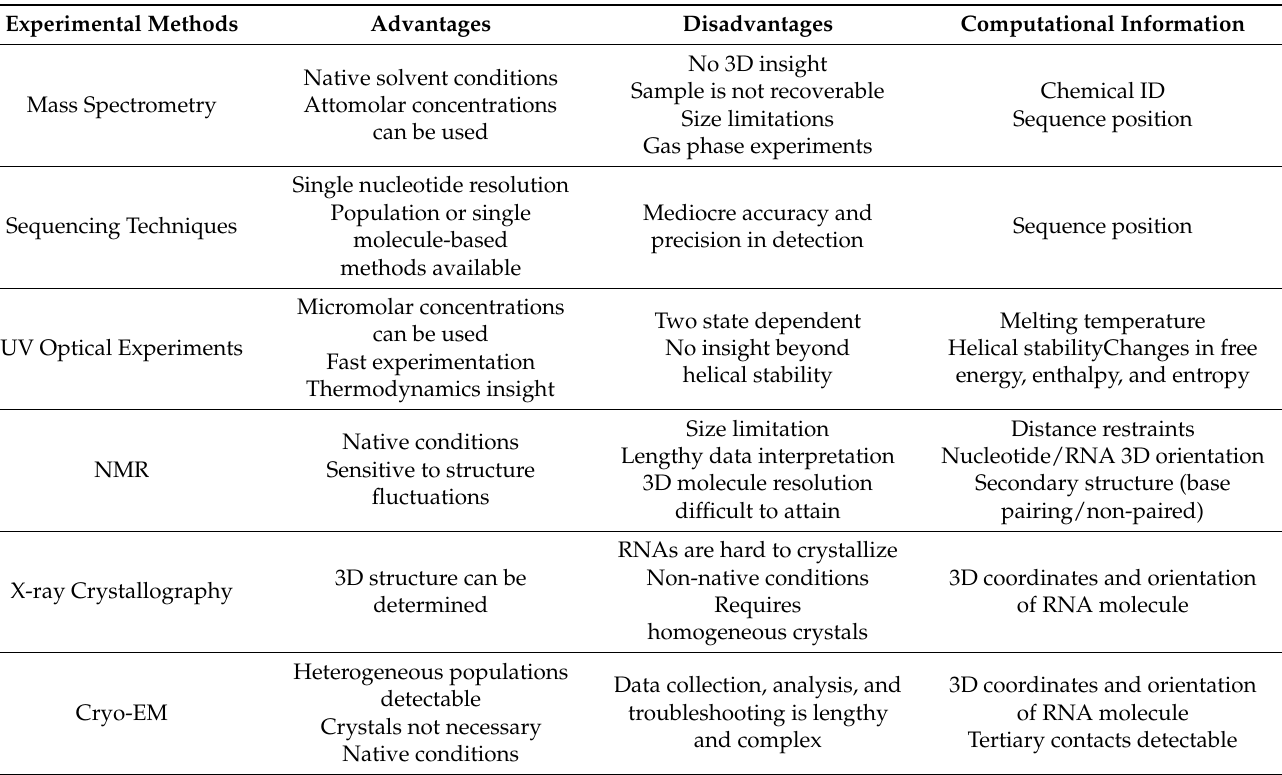
Table 1. Summary of techniques discussed: advantages, disadvantages, and the computational information for RNA modifications that can be gleaned from